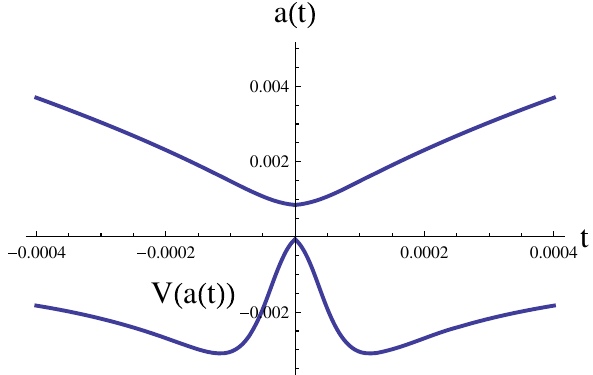
Fig. 10 Illustration of a sewn sudden singularity. The model with neg- ative (cid:3) γ has a mirror symmetry with respect to the cosmological time. Note that the spike on the diagram shows a discontinuity of the function ∂ V = ∂ a . Note the existence of a bounce at t